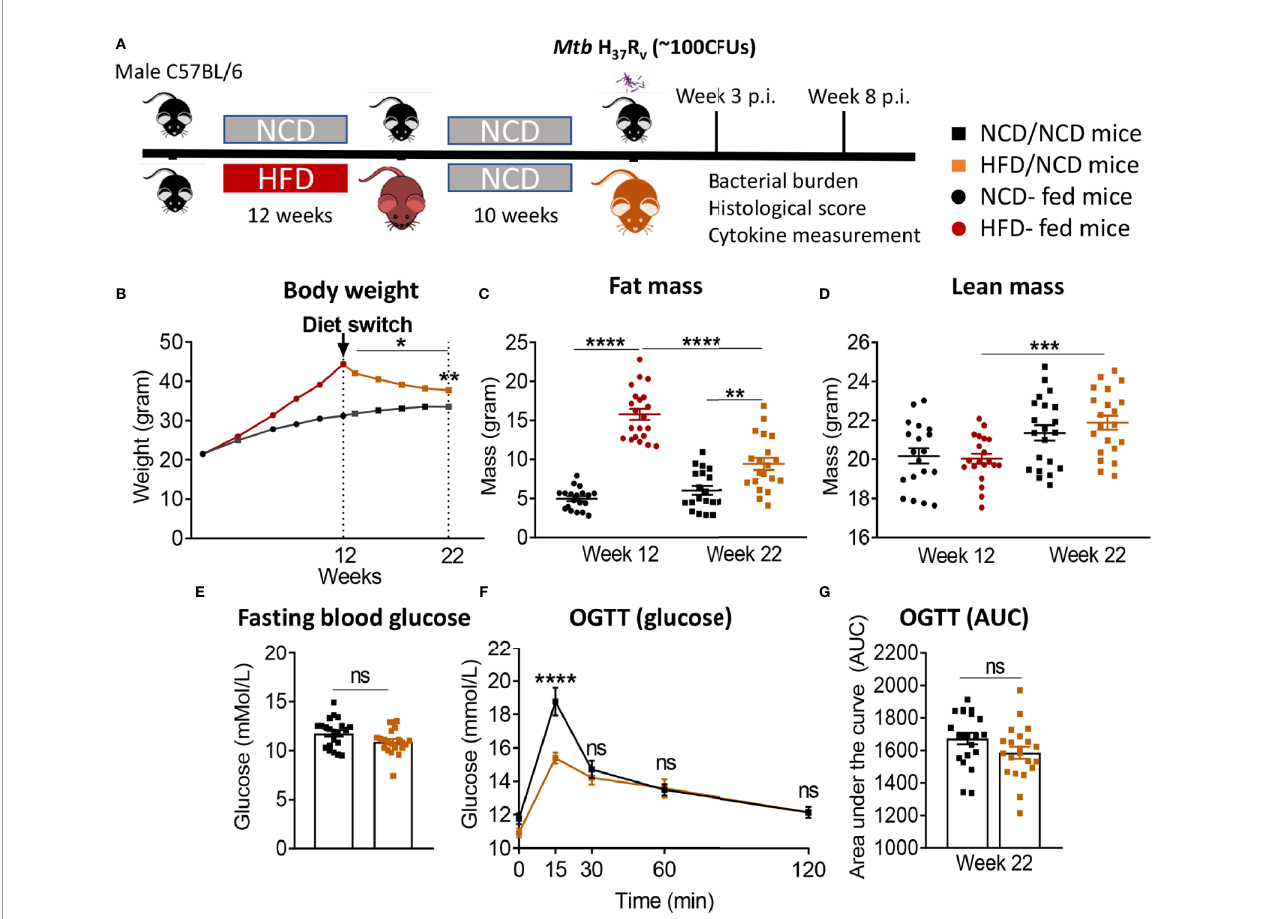
FIGURE 5 | Diet reversal restores glucose tolerance while maintaining higher fat mass. (A) Schematic showing experimental plan for diet reversal-TB model development. (B) Body weight of mice were monitored up to 22 weeks of diet; (C) Fat mass and (D) lean mass were measured. OGTT was performed on NCD/ NCD and HFD/NCD mice; (E) Fasting blood glucose (F) Blood glucose concentrations at baseline, 15, 30, 60, 120 minutes after oral glucose administration and (G) Area under curve (AUC). Data represents mean ± SEM, (n=19-20 mice/group). Data analysis was performed by Mann-Whitney U test. ns=not signi fi cant, *p <